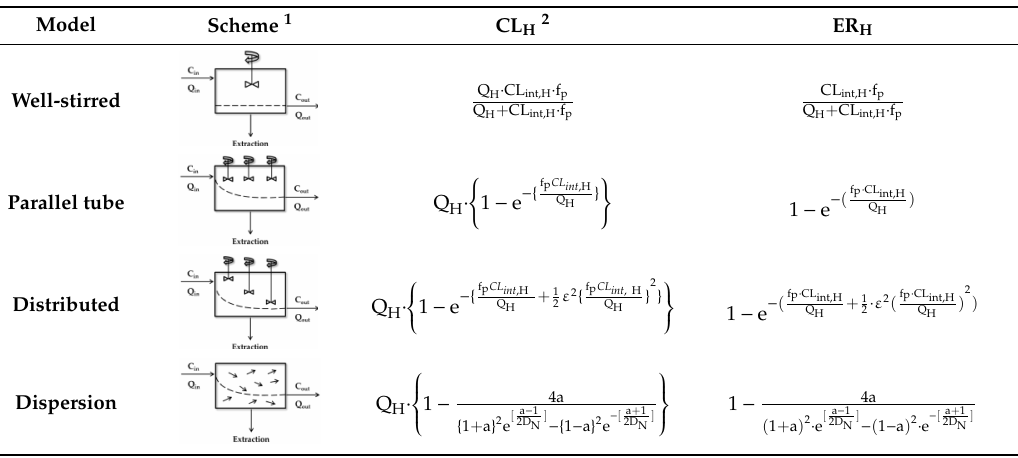
Table 1. Four hepatic clearance